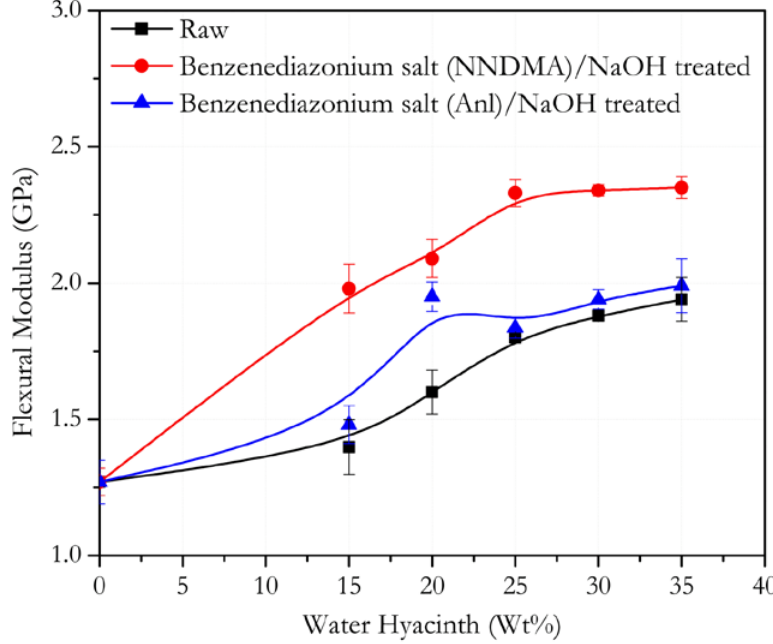
Figure 6: Flexural modulus as a function of fiber loading in WH-PP